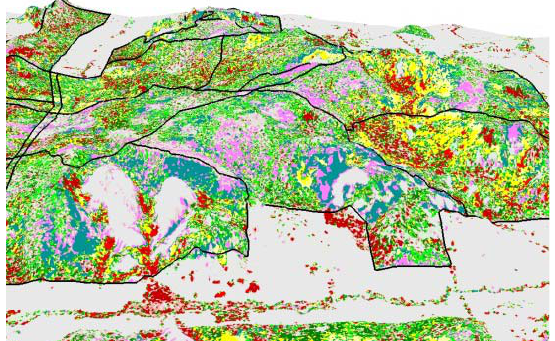
Figure 2. Birds-eye view (elevation exaggerated by a factor 5) highlighting vegetated areas with distinct vertical profiles throughout the western part of Boyagin Nature Reserve (the orange arrow on the left indicates the direction of view). It shows the complex nature of the terrain, and strong associations between canopy structure and position in the landscape. See Table 1 for the legend and description of the